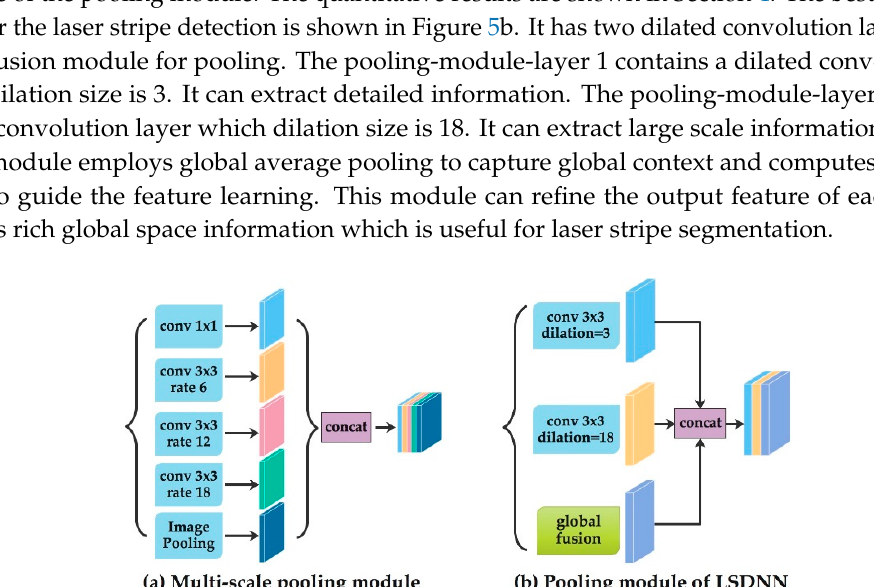
Table 2. Architecture of LSDNN.